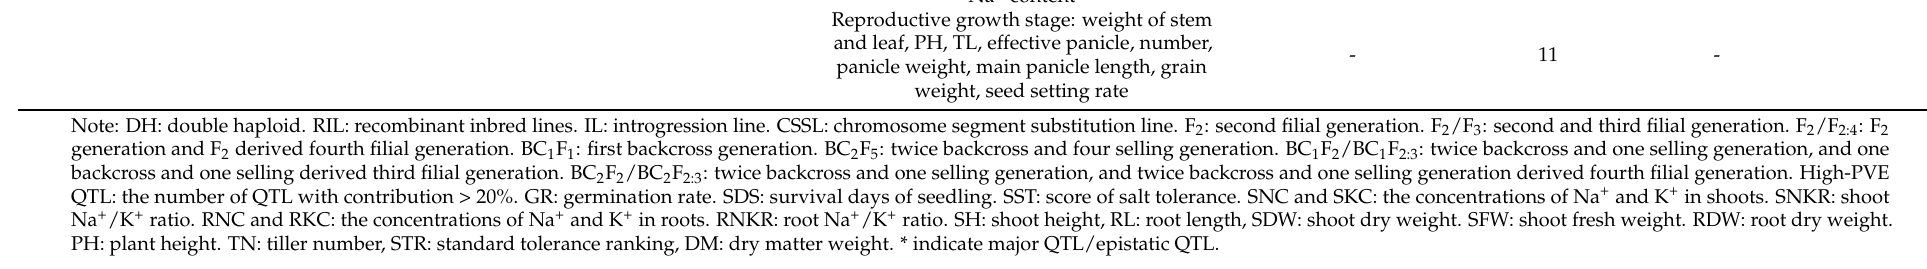
Table 1. Cont. Vegetative growth stage: SST, SFW, SDW, - 4 - [57] Na + content Reproductive growth stage: weight of stem and leaf, PH, TL, effective panicle, number, - 11 panicle weight, main panicle length, grain weight, seed setting rate